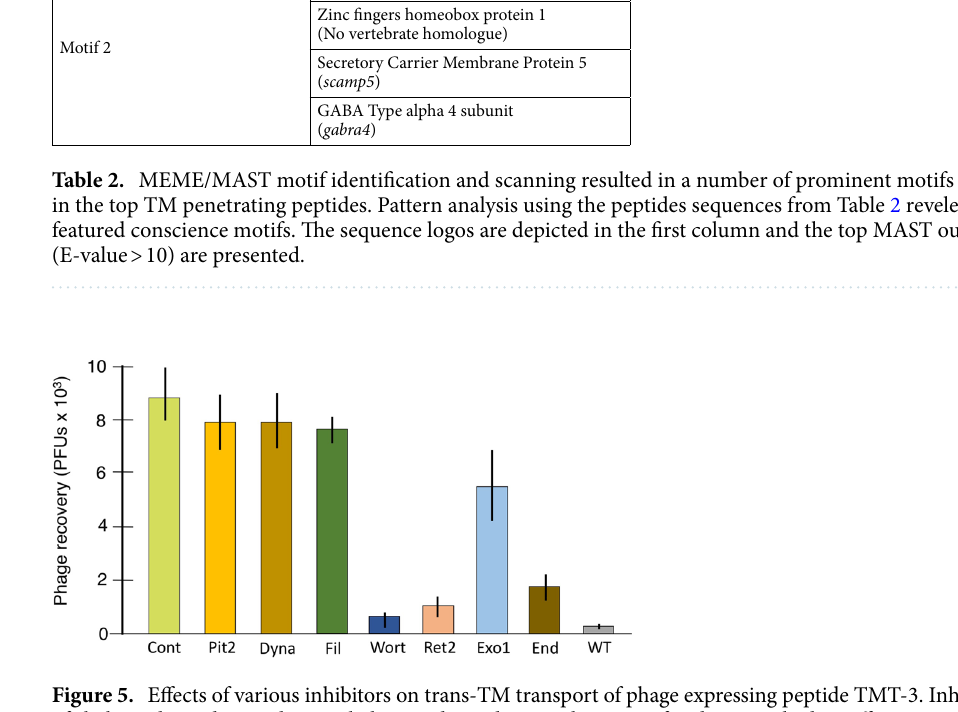
Figure 5. Effects of various inhibitors on trans-TM transport of phage expressing peptide TMT-3. Inhibitors of clathrin-dependent and most clathrin-independent mechanisms of endocytosis had no effect on trans-TM transport. Inhibitors of macropinocytosis (wortmannin), retrograde transport into the Golgi network (Retro-2) and exocytosis (Exo-1 and Endosidin-2) significantly reduced transport (n = 6